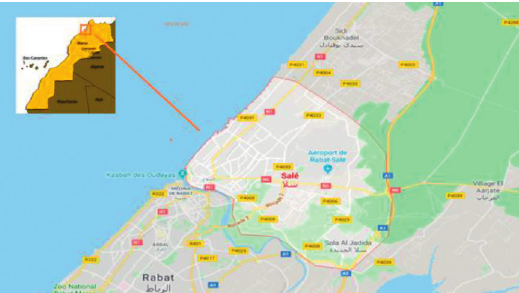
Figure 1: Location of the city of Sale on the graphic map of